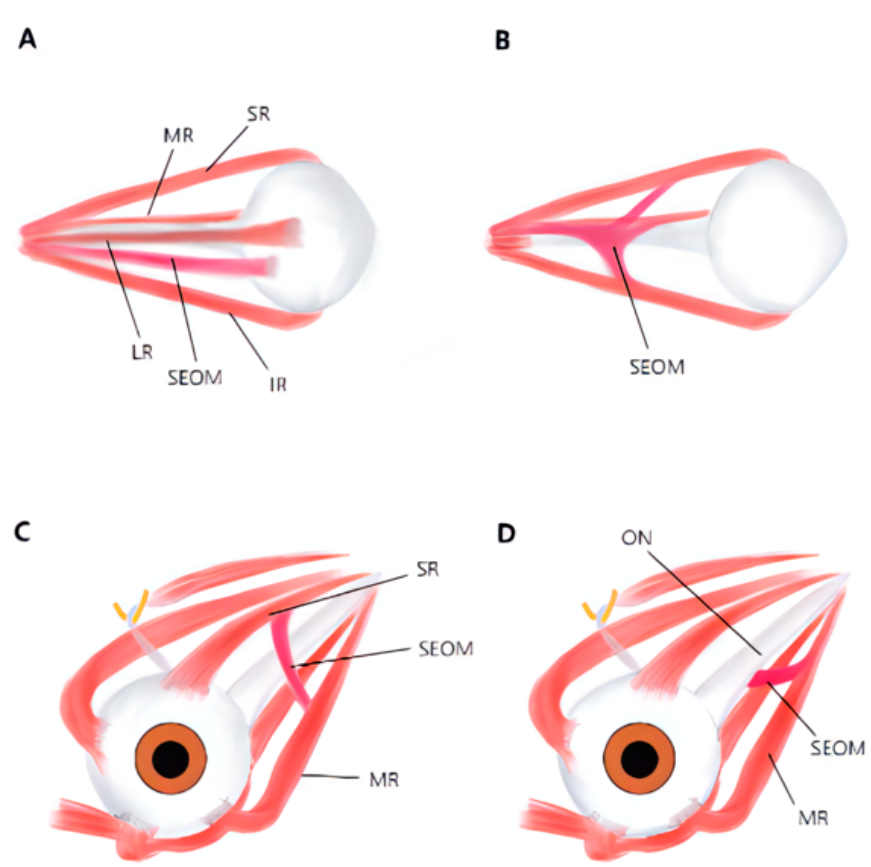
Figure 5. Diagram showing four types of supernumerary extraocular muscles (SEOMs): ( A ) type 1 coursing from orbital apex to posterior part of globe; ( B ) type 2 from Zinn annulus to other recti; ( C ) type 3 connecting recti with or without optic nerve (ON) involvement; ( D ) type 4 only connecting rectus and ON. SR: superior rectus; IR: inferior rectus; LR: lateral rectus; MR: medial rectus.